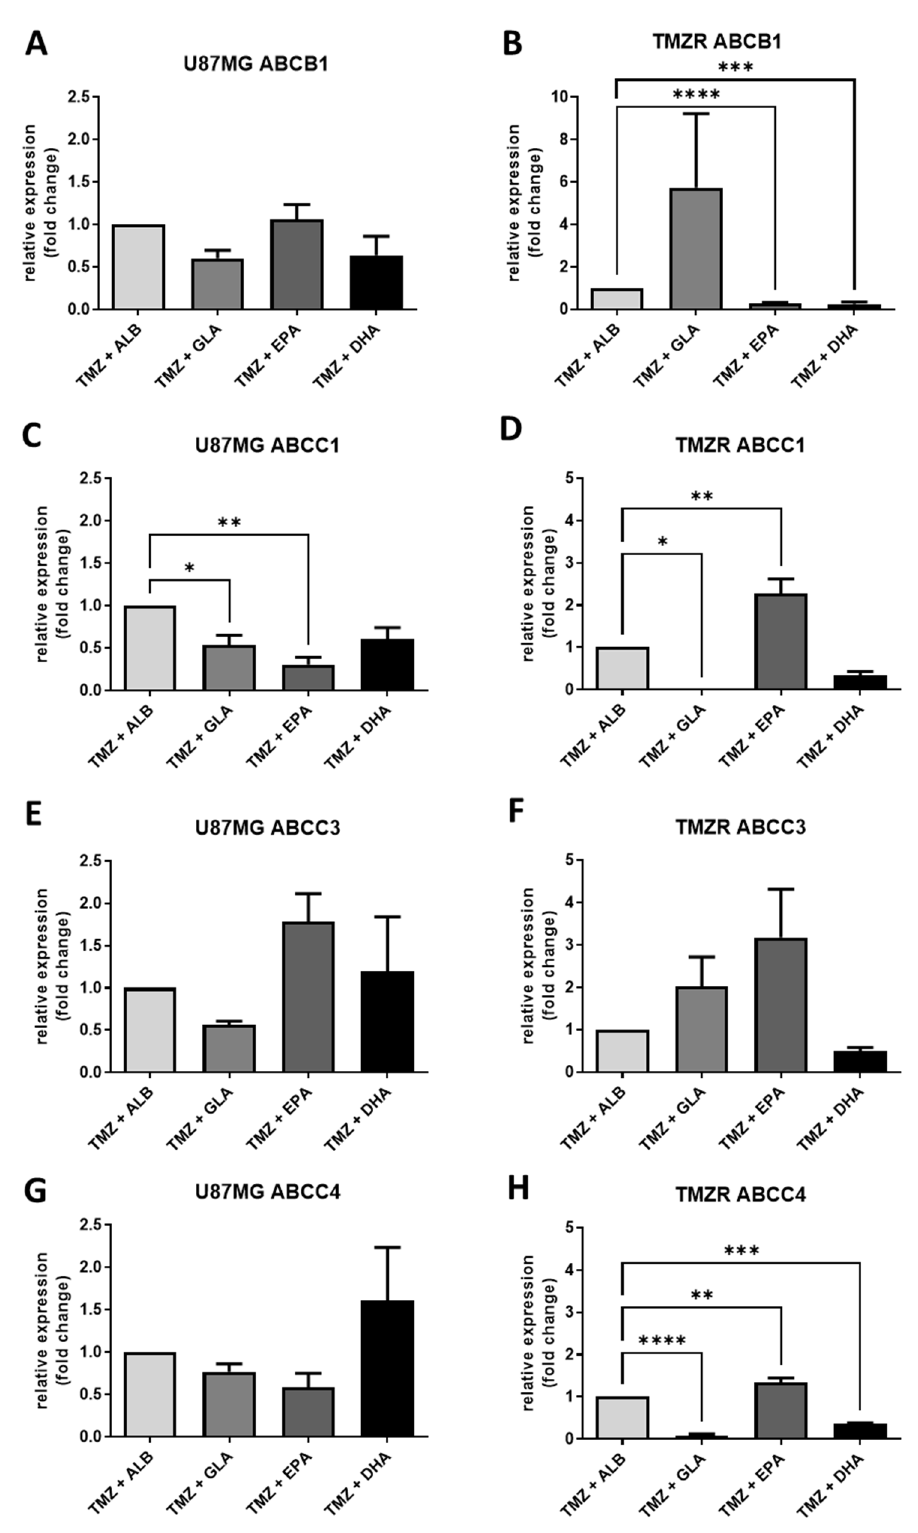
Figure 9. Effects of gamma-linolenic acid (GLA), eicosapentaenoic acid (EPA), and docosahexaenoic acid (DHA) on mRNA expression of ABC transporters. ( A , C , E , G ) ABCB1, ABCC1, ABCC3, and ABCC4 in U87MG cells; ( B , D , F , H ) ABCB1, ABCC1, ABCC3, and ABCC4 in TMZR cells;. Data are presented as mean ± SEM, N = 3. Differences were considered significant at p < 0.05. * = p < 0.05; ** = p < 0.01; *** = p < 0.001; ****= p < 0.0001.